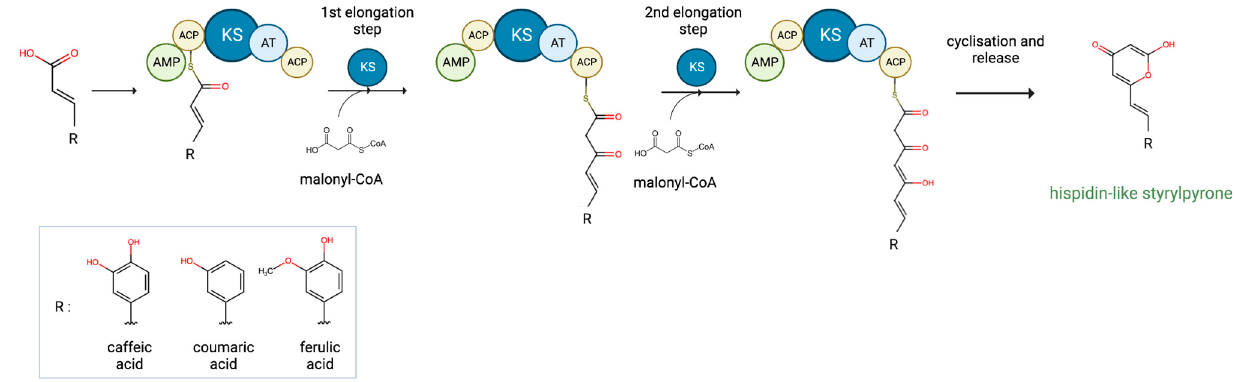
Figure 5. Proposed biosynthetic mechanism of styrylpyrones by nnHispS depending on a substrate. KS—ketosynthase, AT—acyltransferase, ACP—acyl carrier protein, AMP—AMP-binding